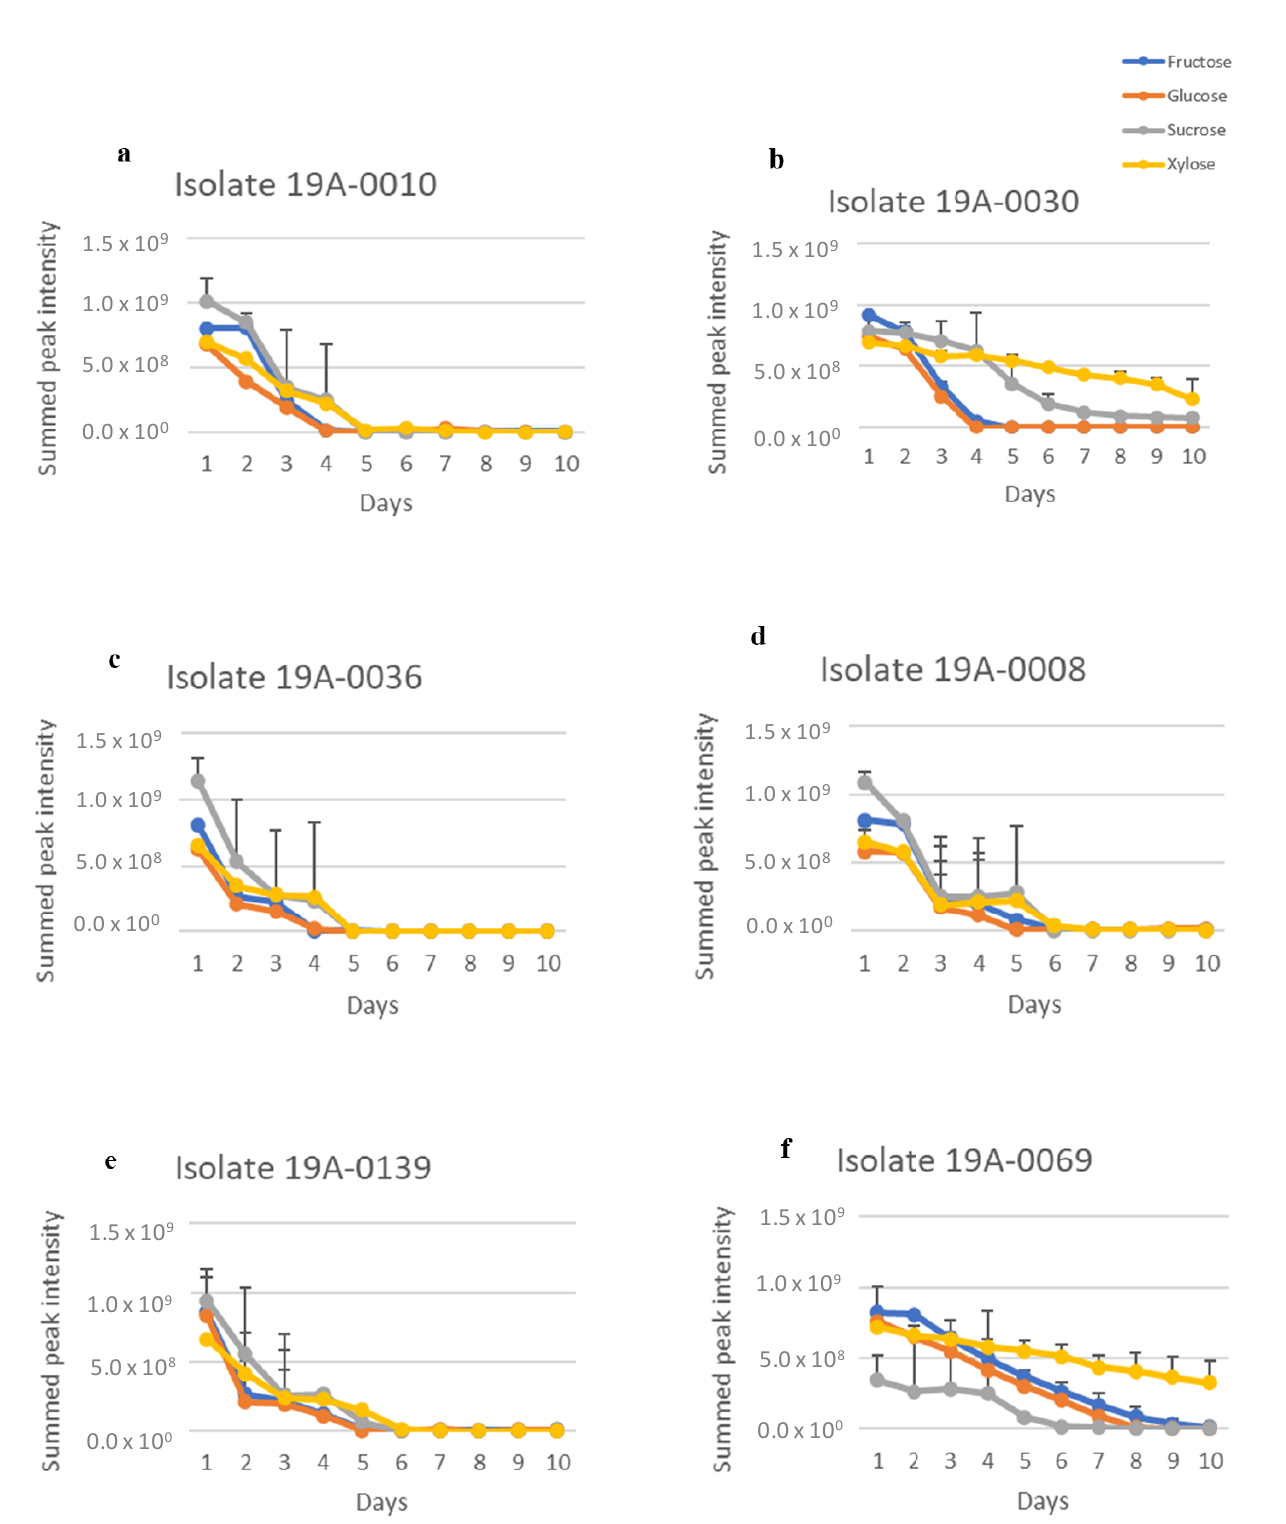
Figure 2. Sugar metabolisation by the different Rhizopus stolonifer isolates when asparagine was the nitrogen source. Data presented are the relative concentration of sugar (as determined from NMR) with standard deviation (error bars), n = 3. ( a ) Isolate 19A–0010, ( b ) isolate 19A–0030, ( c ) isolate 19A–0036, ( d ) isolate 19A–0008, ( e ) isolate 19A–0139, ( f ) isolate